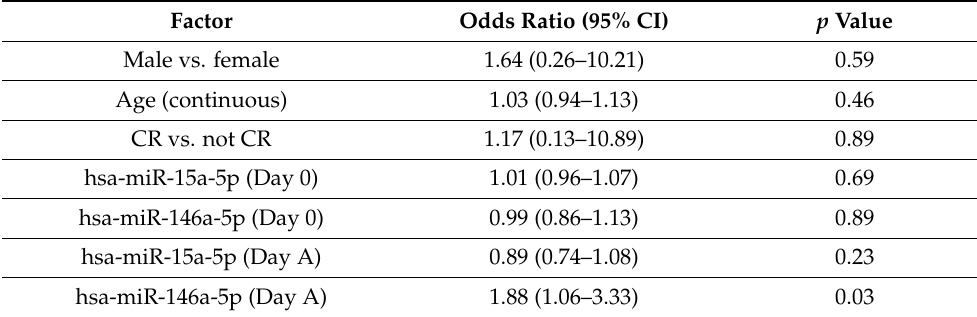
Table 2. Univariate analysis of factors associated with achievement of at least 20 CD34+ cells/µL in peripheral blood before first apheresis.